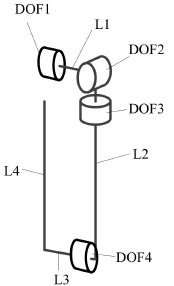
Figure 3. Wearable manipulators with TPEE DOF allocation